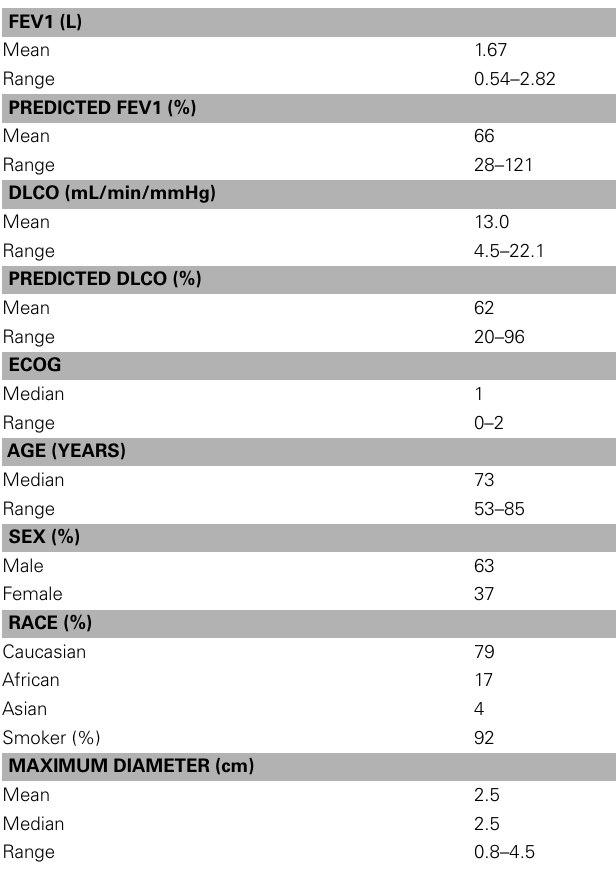
Table 2 | Patient and tumor characteristics. Table 3 |Treatment